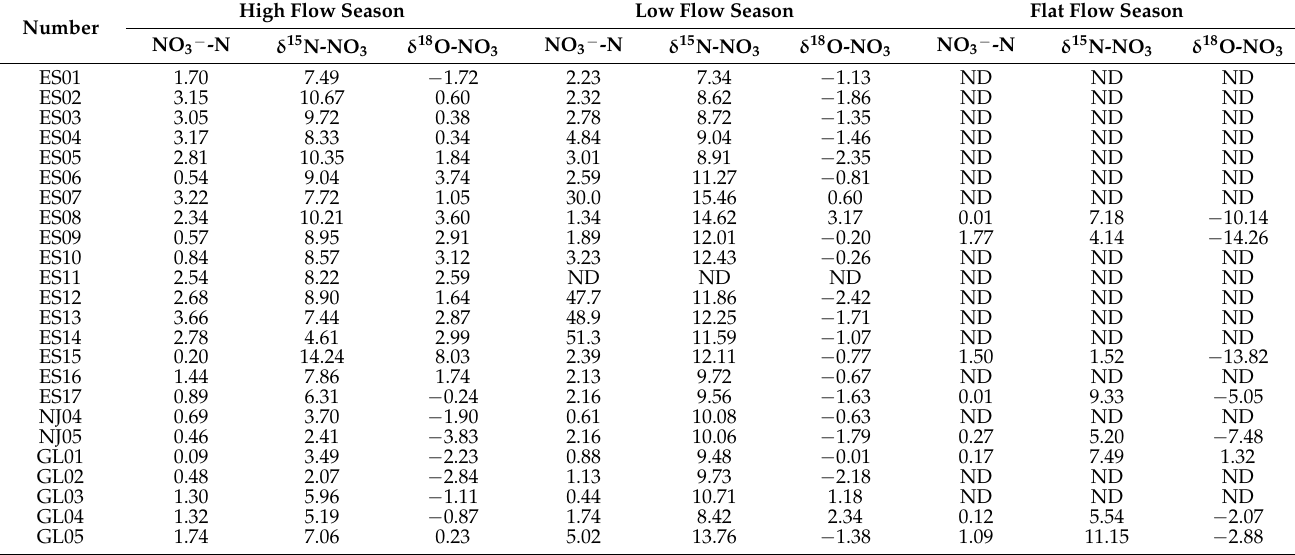
Table 3. Values of δ 15 N-NO 3 and δ 18 O-NO 3 in different